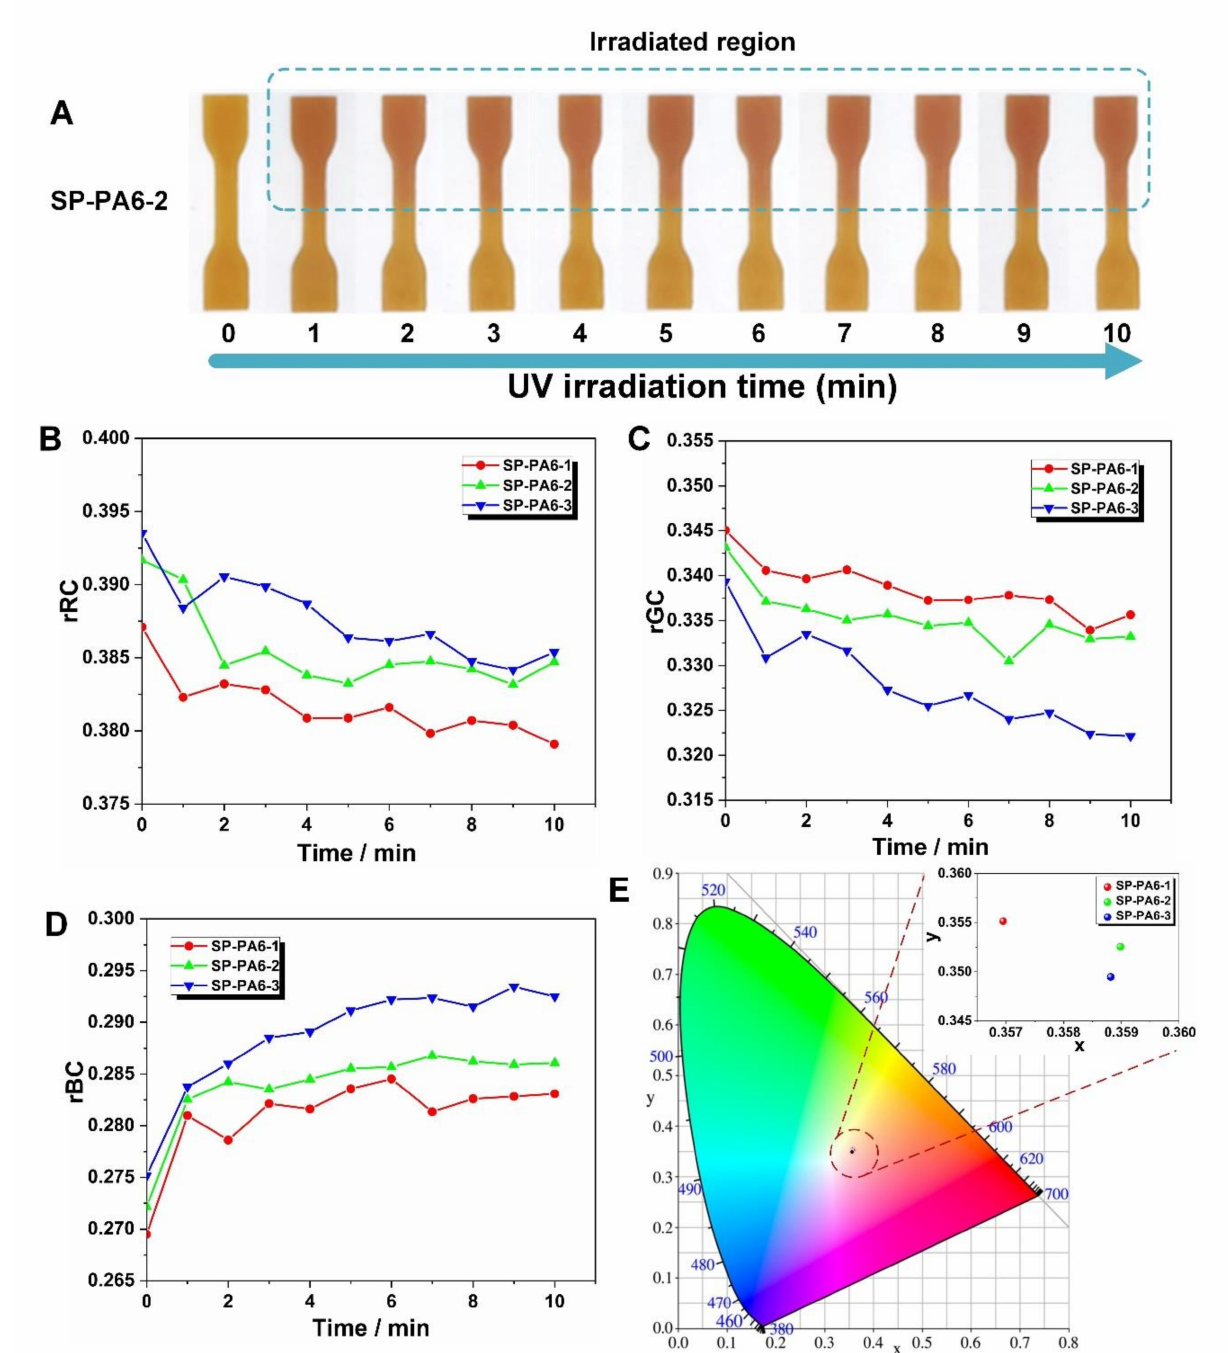
Figure 6. ( A ) Photographs of SP-PA6-2 after UV irradiation for different times. ( B ) rRC (red), ( C ) rGC (green) and ( D ) rBC (blue) signals as a function of irradiation time for different test samples. ( E ) The CIE 1931 chromaticity diagram of SP-PA6-1, SP-PA6-2 and SP-PA6-3 after being irradiated for 1